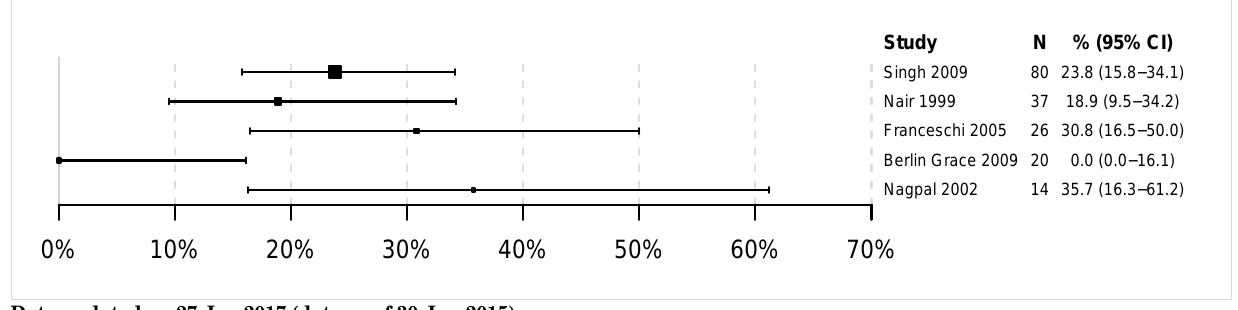
Figure 57: HPV 16 prevalence among women with low-grade cervical lesions in India, by study